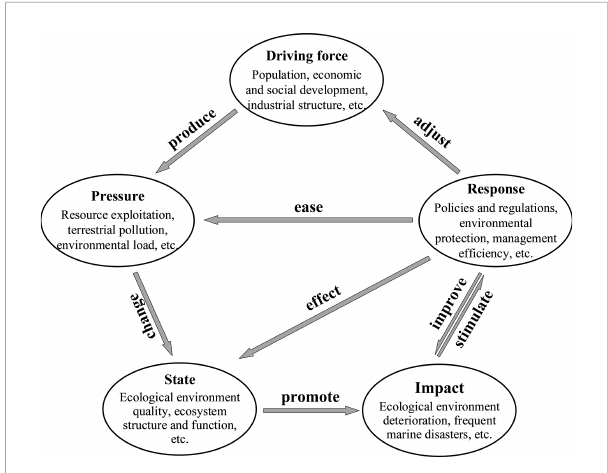
FIGURE 2 The DPSIR conceptual model for the ecosystem health assessment indicator framework in Laizhou Bay.